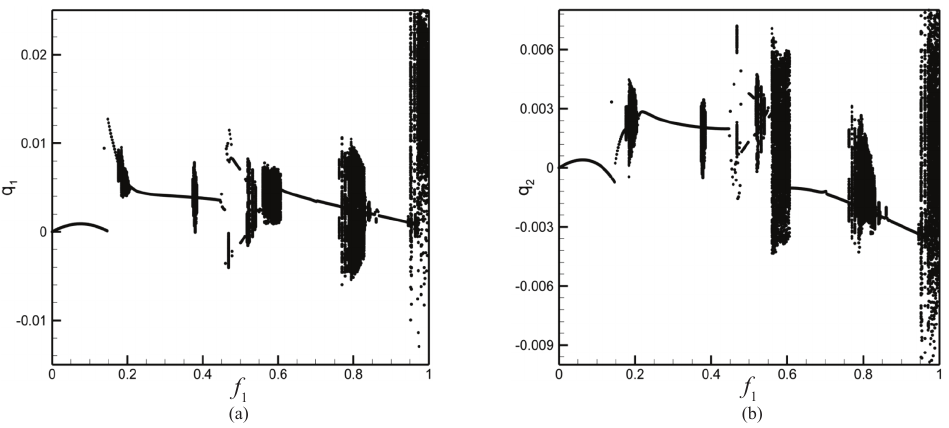
Fig. 19. Bifurcation diagrams of Poincaré points for increasing forcing amplitude on the system with γ T = 1 . 0 .